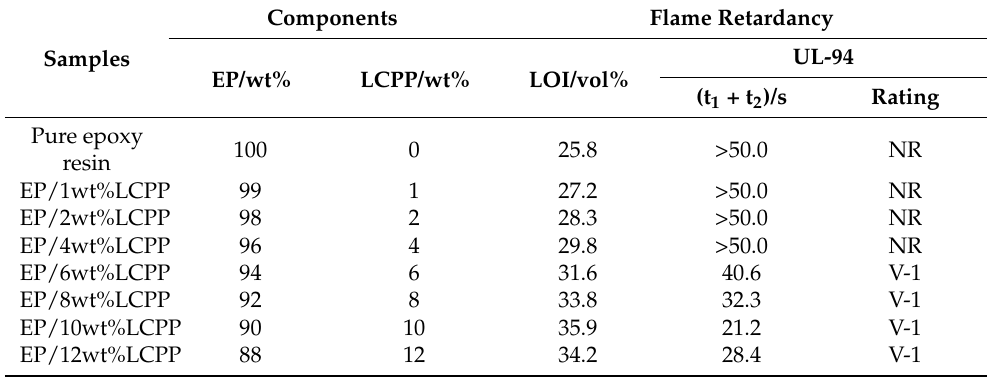
Table 1. Ingredients of the EP composites and the corresponding LOI values and UL-94